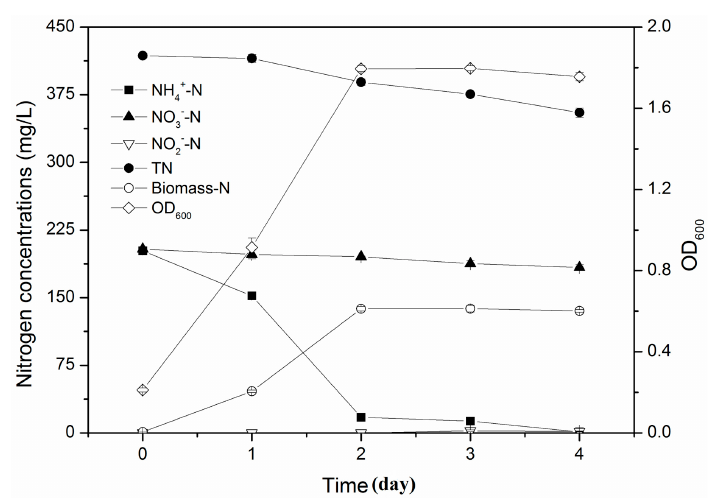
Figure 4. Simultaneous nitrification and denitrification characteristics of strain Y-12 in the presence of NH 4+ -N and NO 3 − -N.